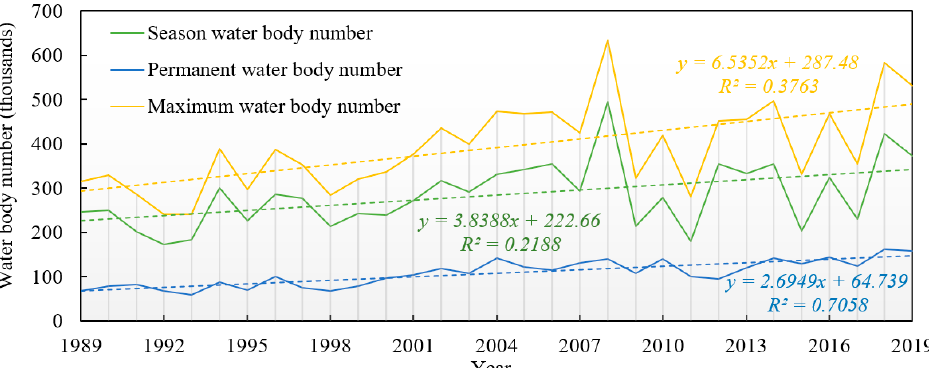
Figure 7. 1989–2019 interannual variation trend of the number of different water types (maximum, seasonal, and permanent) in the Hetao Plain.